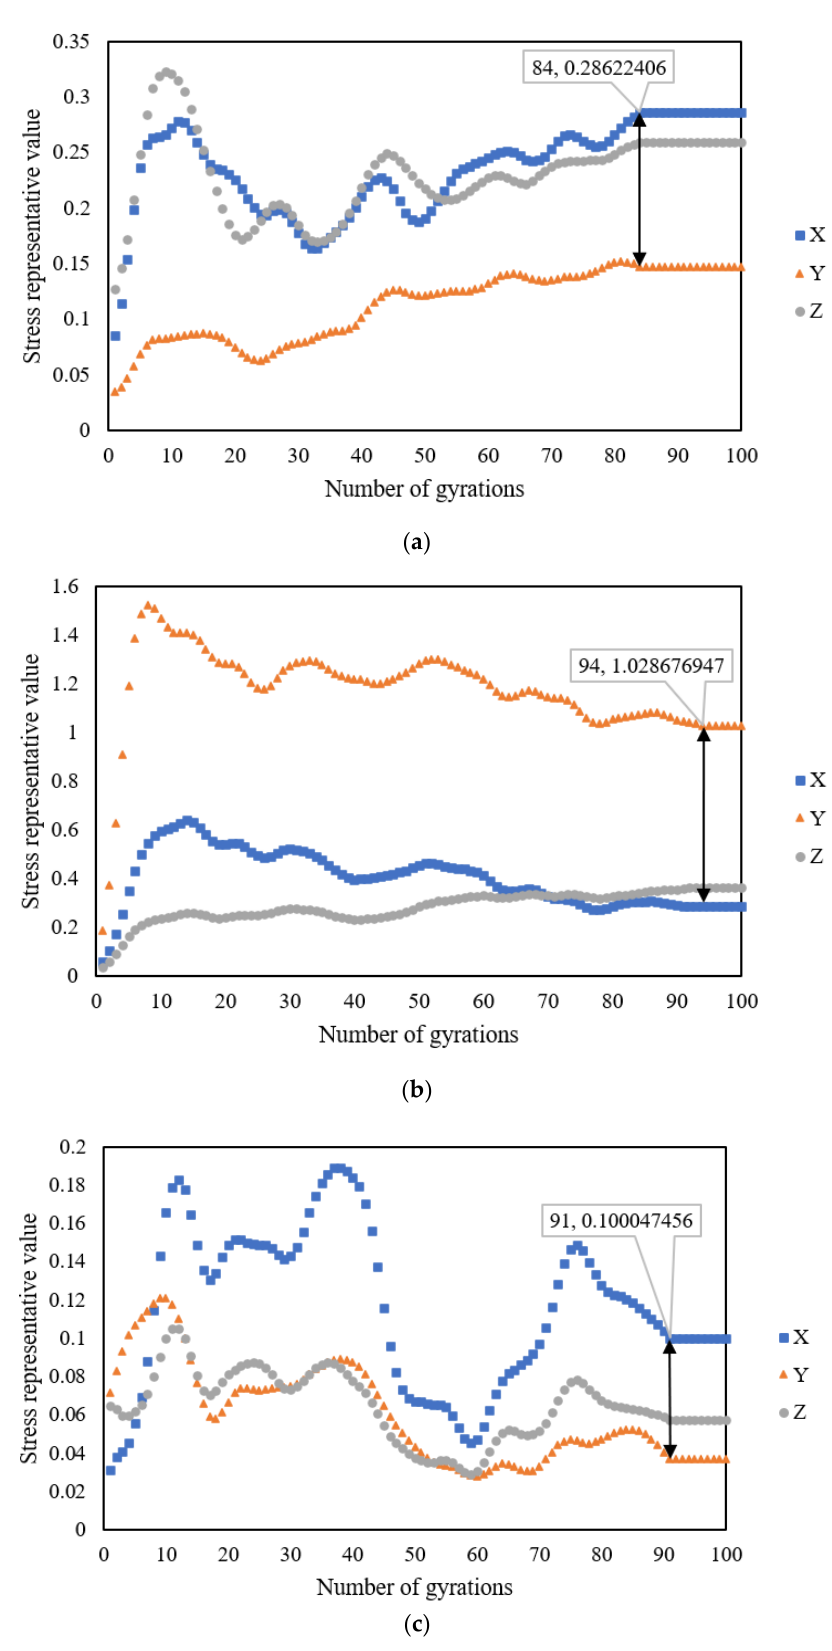
Figure 8. Representative stress value in the SmartRock’s various embedded positions: ( a ) top, ( b ) center, and ( c ) bottom.